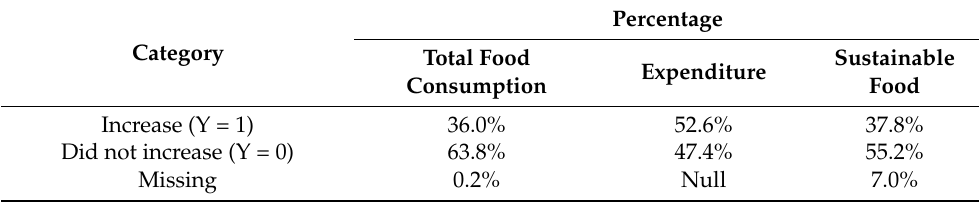
Table 3. Behavioral changes during the